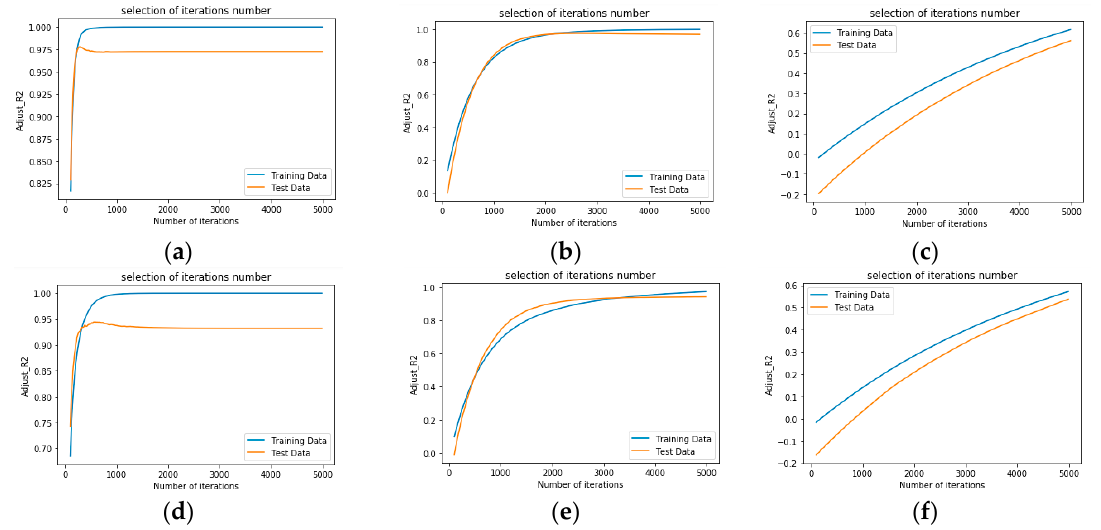
Figure 7. The change in adjusted_R 2 based on gradient boosting decision tree (GBDT) as the number of iterations increases. ( a ) Shahu Port: learning rate = 0.01, subsample = 0.5. ( b ) Shahu Port: learning rate = 0.001, subsample = 0.5. ( c ) Shahu Port: learning rate = 0.0001, subsample = 1. ( d ) Xunsi River: learning rate = 0.01, subsample = 0.5. ( e ) Xunsi River: learning rate = 0.001, subsample = 0.5. ( f ) Xunsi River: learning rate = 0.0001, subsample = 1.